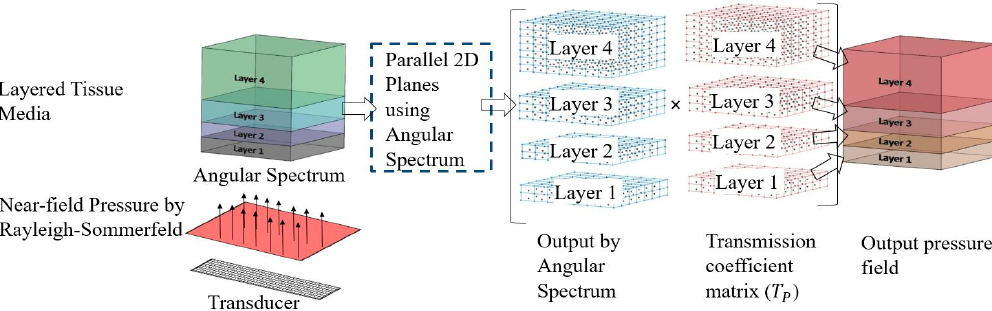
Figure 3. Schematic of 3D continuous-wave pressure field calculation in layered tissue media.